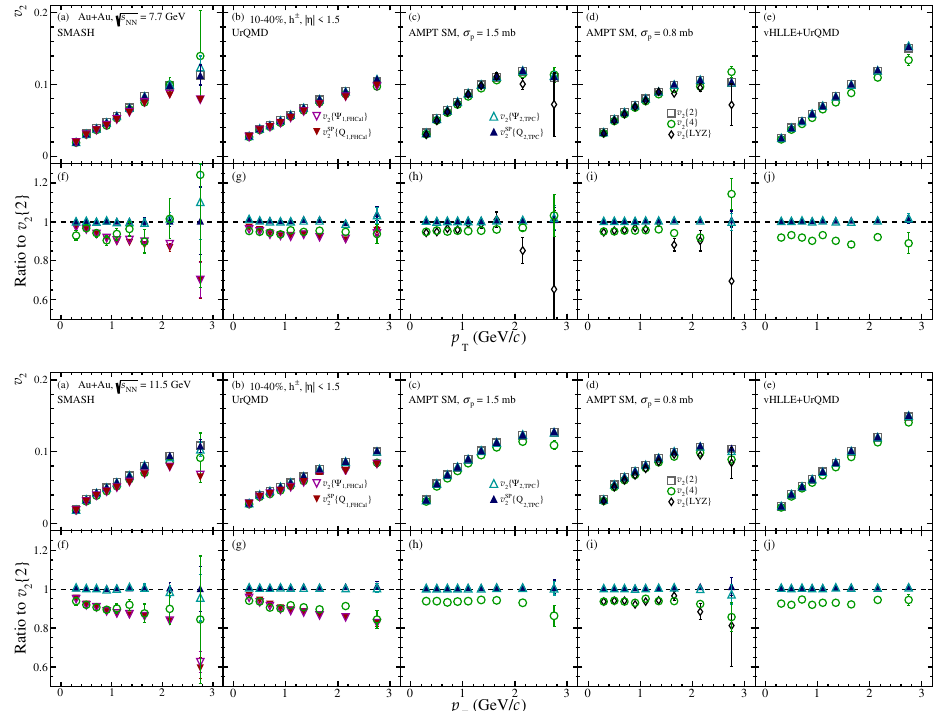
Figure 5. p T -dependence of v 2 of inclusive charged hadrons in 10–40% central Au+Au collisions √ s NN = 7.7 and 11.5 GeV measured by different methods. Panels ( a – e ) correspond to different at models. Panels ( f – j ) show the v 2 { method } / v 2 { 2 }